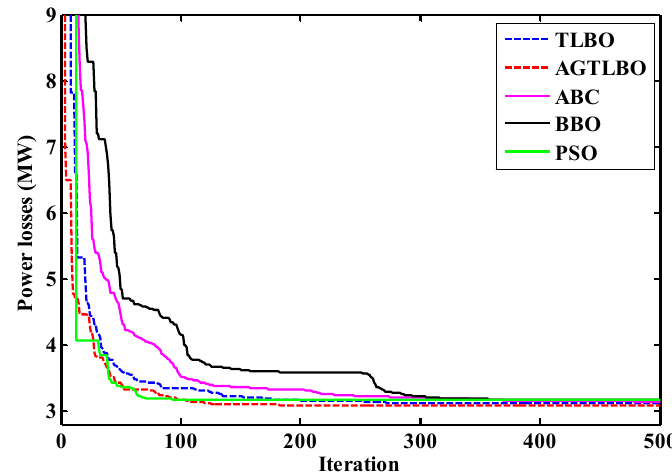
Figure 10. Convergence characteristics for Case 4.